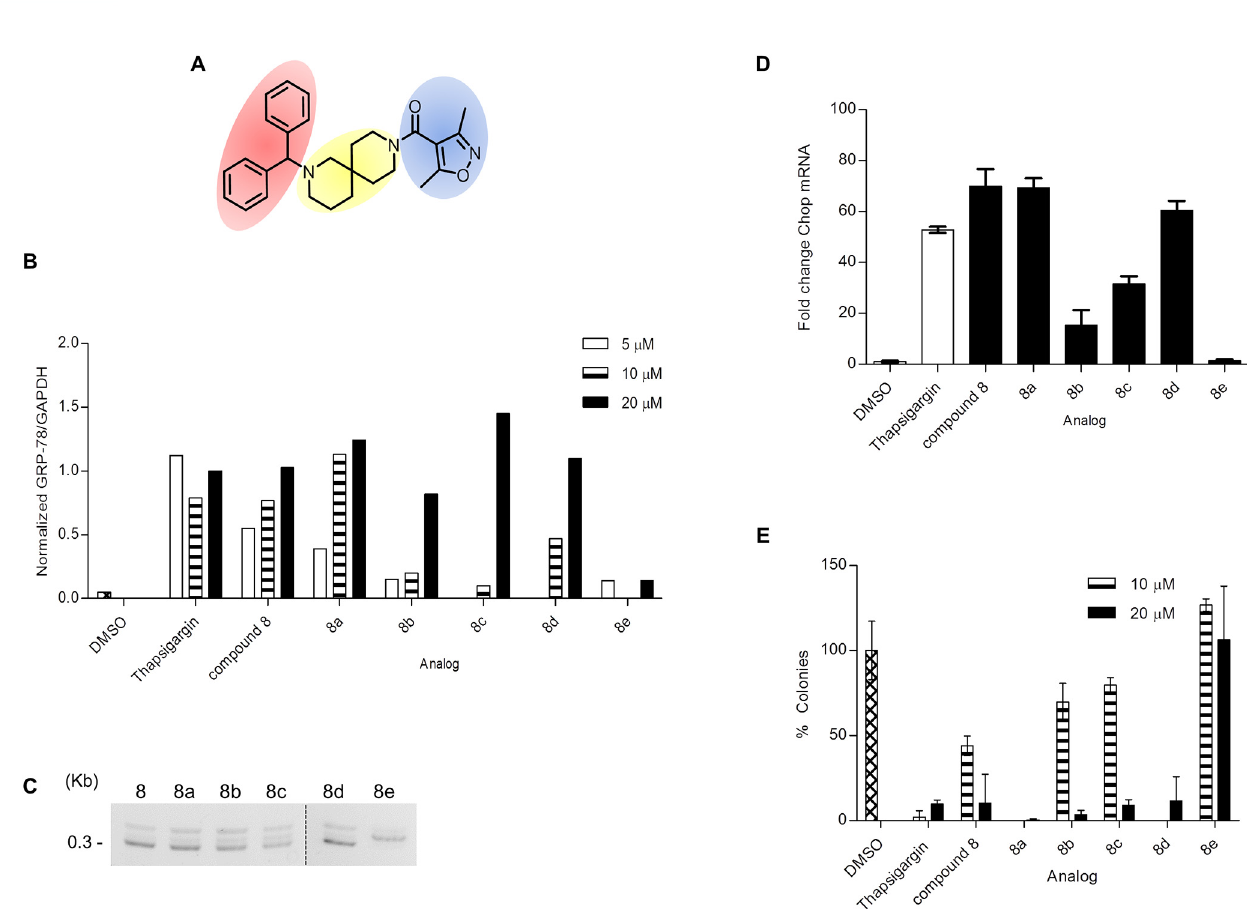
Fig 4. Structure-Activity Relationship for compound 8. (A) Structure of compound 8 . The 2,9-diazaspiro[5.5]undecane spirocyclic core, the diphenylmethyl group and the 3,5-dimethylisoxazole moiety are highlighted in yellow, red and blue, respectively. (B) U87-MG cells treated with the indicated analogs were analyzed by immunoblot for GRP78 expression. GAPDH levels were used as housekeeping controls. Data are represented as GRP78/GAPDH ratio for each compound and normalized to the GRP78/GAPDH ratio for 20 μ M thapsigargin. See S3 Fig for blot images. (C) U87-MG cells were treated with DMSO, 1 μ M thapsigargin or 20 μ M of indicated analog for 16 h. XBP-1 mRNA splicing was monitored by RT-PCR using XBP-1-specific primers, which amplify a spliced or unspliced fragment of 304 or 326 bp, respectively. (D) U87-MG cells were treated with DMSO, 1 μ M thapsigargin or 20 μ M of indicated compound for 24 h. CHOP and housekeeping GAPDH mRNA levels were monitored by qRT-PCR. Data is plotted relative to the DMSO treated sample set to 1. Error bars indicate the SD of three replicates. (E) U87-MG cells treated with the indicated compounds were tested for their ability to form colonies. Data are represented as the number of colonies, normalized to vehicle DMSO. Error bars indicate SE with n = 3. Note that 8e is an inactive control. Analogs 8a and 8d were tested only at 20 μ M. See S7 Fig for representative